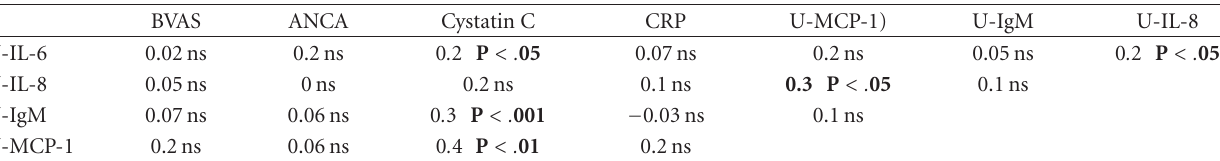
Table 4: Correlation matrix. U = urine, MCP-1 = monocyte chemoattractant protein 1, IgM = immunoglobulin M, IL-6 = interleukin 6, IL-8 = interleukin 8, ANCA = anti neutrophil cytoplasmatic autoantibodies, CRP = C-reactive protein, BVAS = Birmingham vasculitis activity score. Markers measured in the urine are expressed in relation to U-creatinine (mmol/l). For statistics, the Spearman’s rank correlation test and simple regression analysis were performed.